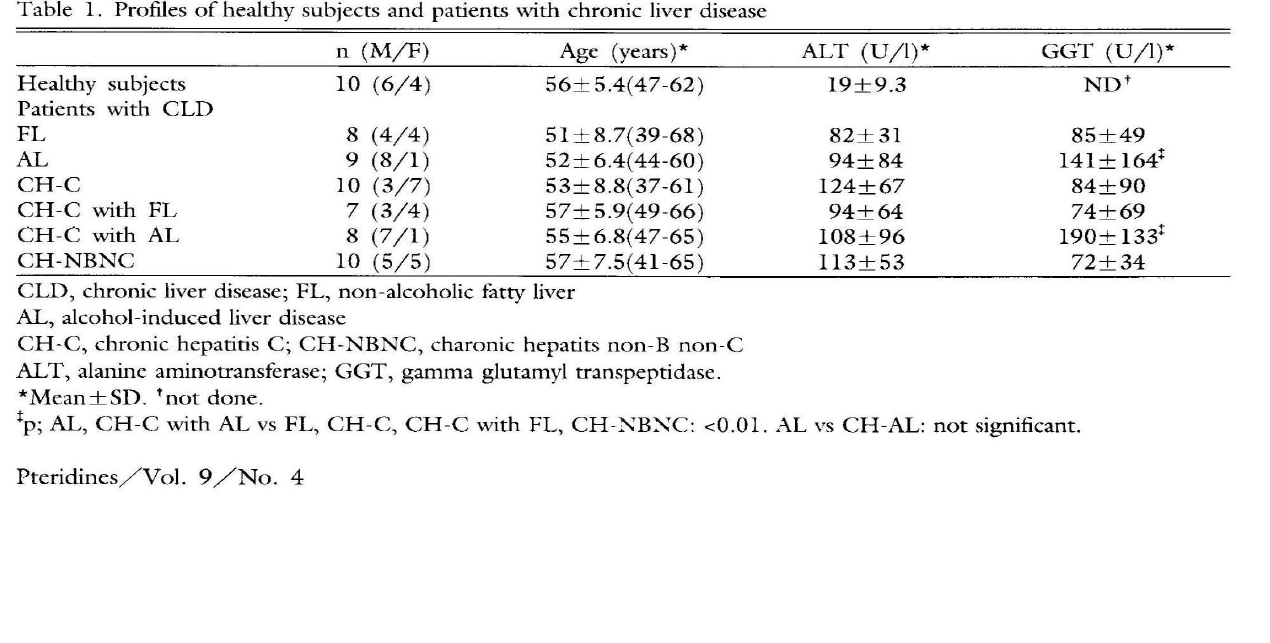
Table 1. Profiles of healthy subjects and patients with chronic liver disease n (MjF) Healthy